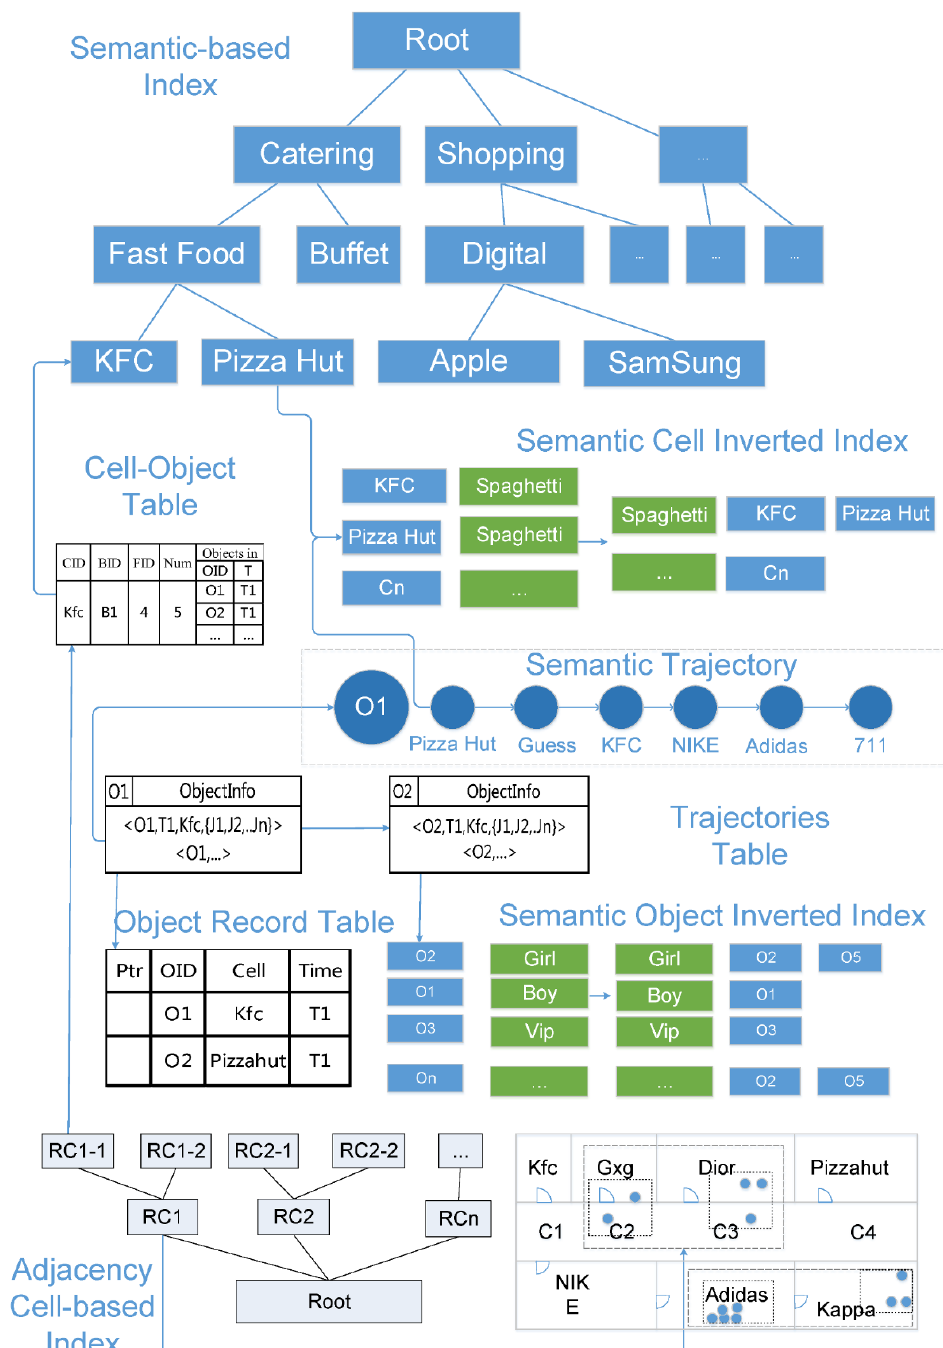
Figure 5. Overall structure of the MACSItree. Dark backgrounds indicate semantic-related